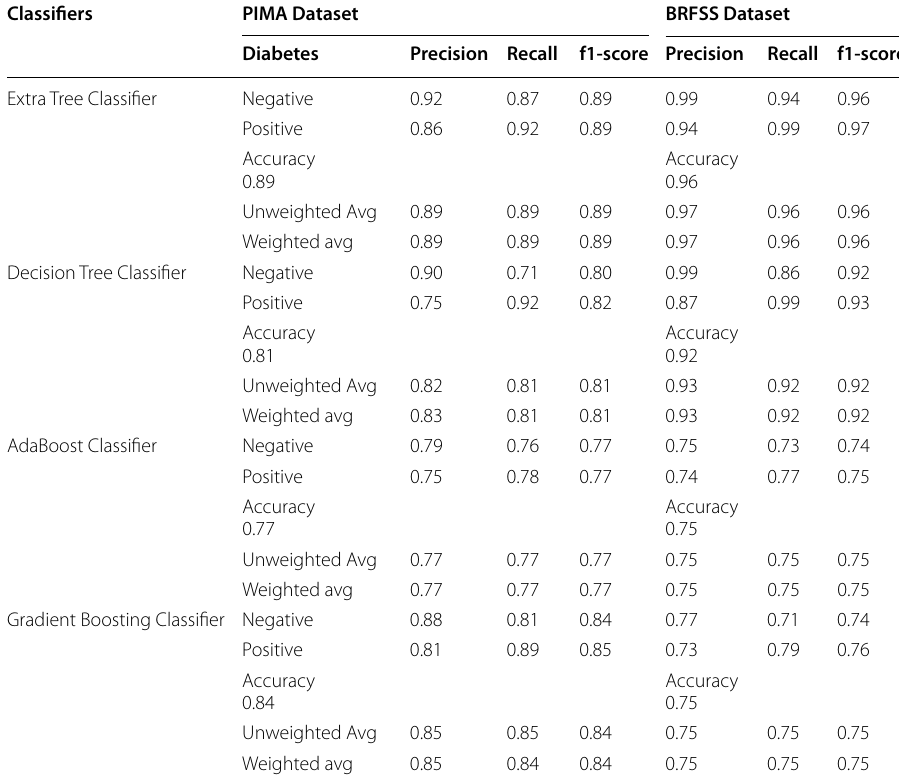
Table 3 The classification report for the selected models and